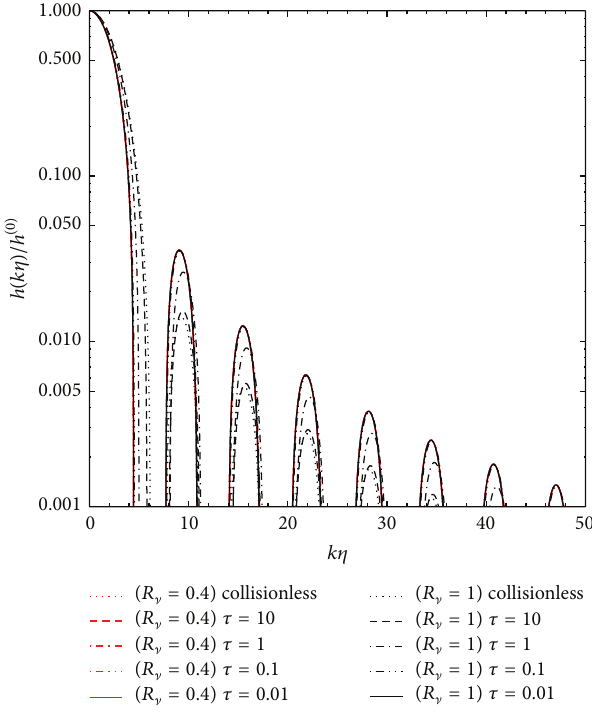
Figure 3: Evolution of the normalized wave amplitude ℎ 𝑖𝑗 /ℎ (0) 𝑖𝑗 as function of 𝑘𝜂 for the RMD scenario in case of including the collision terms. Results are for 𝜏 = 0.01, 0.1, 1 , and 10 and for the collisionless case. 𝜏 is given in units of 𝜂 0 and 𝑘 in units of 1/𝜂 0 . We have considered three neutrino species with 𝑅 ] = 0.4052(0.4) (red lines) and the extreme case of a huge number of neutrino species with 𝑅 ] = 1 (black lines). The RMD curves are correctly interpreted = 1 (see also Figure 8 for comparison). by observing that 𝑘𝜂 eq